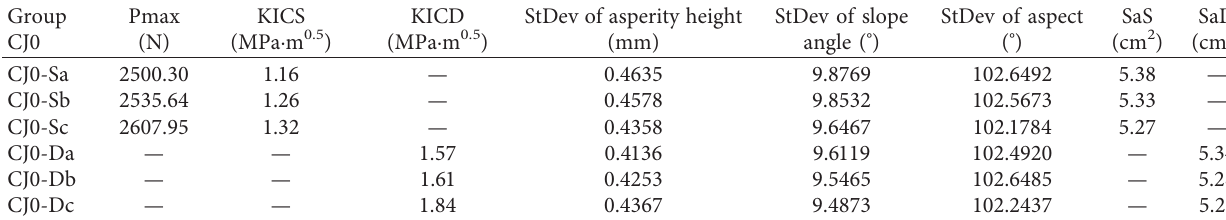
Table 3: Experimental results of the specimens of group